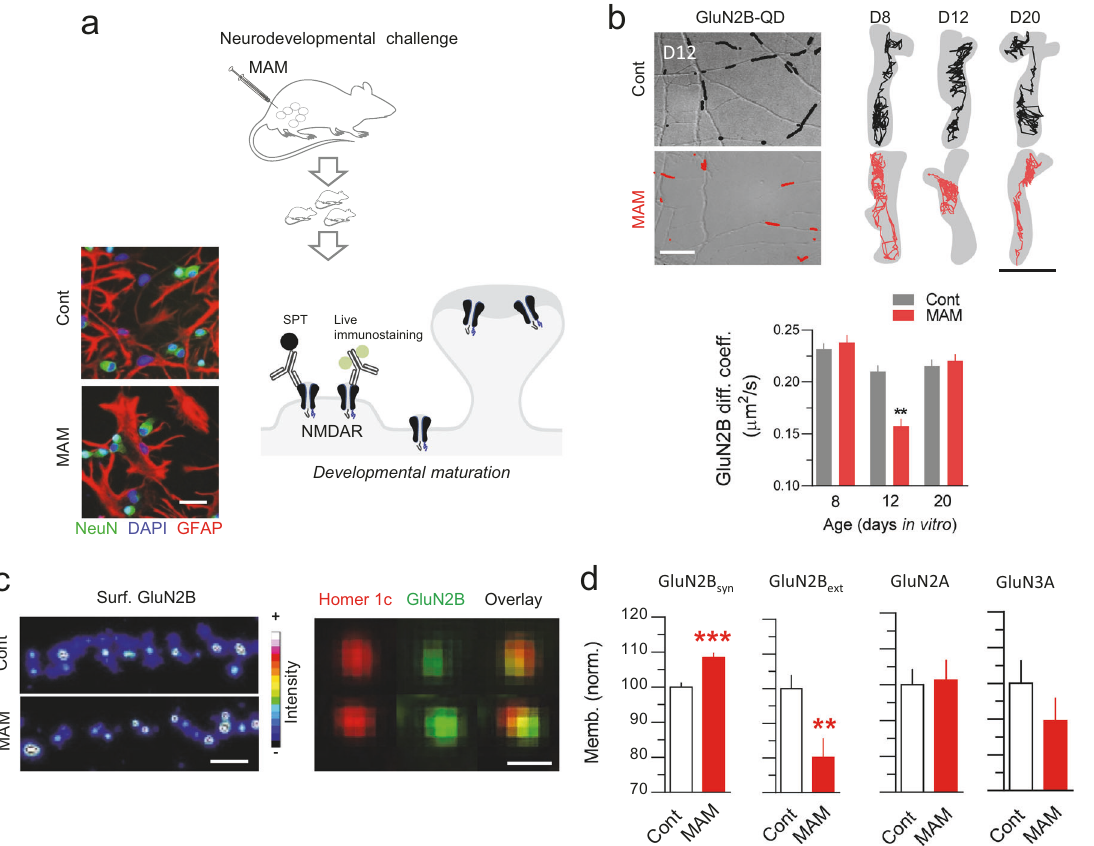
Fig. 4 NMDAR surface dynamics and synaptic plasticity are developmentally impaired in the MAM model. a Schematic description of the experimental work fl ow. Cultured hippocampal networks were made from rat pups. Examples of immuncytochemical staining of neurons (NeuN, green), nucleus (DAPI, blue), and glial cells (GFAP, red) in cultured network at 10 days in vitro from control or MAM-exposed pups. b Representative trajectories (50 ms acquisition) of surface GluN2B-NMDAR-QD complexes on neurons from control or MAM-exposed pups at three developmental stages: days in vitro 6 – 10 (D8), days in vitro 10 – 15 (D12), days in vitro 15 – 22 (D20). Scale bars = 5 µm/300 nm (left/right). Right, Comparison of GluN2B-NMDAR diffusion coef fi cient control or MAM-exposed conditions (D8 cont, n = 1916 trajectories; D8 MAM, n = 1220; D12 cont, n = 2055; D12 MAM, n = 946; D20 cont, n = 1288; D20 MAM, n = 1317; ** p < 0.01, Mann – Whitney test). Data are represented as mean ± sem. c Surface immunostaining of GluN2B-NMDAR onto neurons from control or MAM-exposed pups (synapses were detected with Homer1c-GFP). Scale bars = 5/1 µm (left/right). d Comparison of the GluN2B, GluN2A, GluN3A-NMDAR cluster areas between conditions (GluN2B synaptic cont, n = 2144 clusters; GluN2B synaptic MAM, n = 2468, *** p < 0.001, Student ’ s t -test; GluN2B extrasynaptic cont, n = 1733; GluN2B extrasynaptic MAM, n = 1421, ** p < 0.01, Student ’ s t -test; GluN2A cont, n = 56; GluN2A MAM, n = 41; GluN3A cont, n = 59; GluN3A MAM, n = MAM: 43 ± 3; MAM TAT-NS: 37 ± 10; MAM TAT-2B (P9): 43 ± 6; between GluN2B-NMDAR and PDZ scaffold proteins in synapses MAM TAT-2B (P12): 45 ± 3; ANOVA 1, F = 0.735, P = 0.57). Thus, the and consequently increase GluN2B-NMDAR surface dynamics (Fig. arti fi cial increase in GluN2B-NMDAR surface dynamics during the 6a, b) [38, 50]. The TAT-2B ligand, or its non-sense control version second postnatal week is suf fi cient to prevent the PPI de fi cit (i.e., TAT-NS), was injected in the dorsal hippocampus of control or observed in adult MAM rats. MAM-exposed rats at (1) P9 in order to favor NMDAR dynamics These results suggest thus the impairment in NMDAR surface during the sensitive altered period, or (2) at the end of the diffusion during the second postnatal week produce behavioral sensitive period (P12) (Fig. 6a). At adult stage (P60-65), the de fi cits at adulthood. To directly test this possibility, we used a synaptic content of NMDAR subunits, measured by western blot in cross-link (x-link) strategy [20, 52, 53]. Schematically, surface synaptosomes, was not signi fi cantly different between control, NMDAR are x-linked by an antibody directed against an MAM-exposed, and TAT-2B-injected (P9) rats (Supplementary Fig. extracellular epitope of the GluN2B subunit, which resulted in 5). We then used the gold-standard PPI test in adult rats, a drastic reduction of the receptor surface dynamics (Fig. 6a, b). behavioral assay consistently affected in MAM-exposed rats Anti-GluN2B or control antibodies were injected in the dorsal [35, 51]. We fi rst con fi rmed that MAM-exposed rats poorly hippocampus at P9. At adult stage (P60-65), the synaptic content responded to PPI (Fig. 6c). Remarkably, the PPI de fi cit was of NMDAR subunits, measured by western blot in synaptosomes, abrogated in MAM-exposed rats when the TAT-2B ligand was was not signi fi cantly different between control and GluN2B-x-link injected at P9; the TAT-NS in MAM-exposed rats or TAT-2B in injected rats (Fig. 6b). When the surface dynamics of GluN2B- control rats had no effect (Fig. 6c). When the TAT-2B ligand was NMDAR was impaired from P9, the PPI response at adulthood was injected later, at P12, MAM-exposed rats still exhibit a poor signi fi cantly impaired (Fig. 6c). However, when the injection was response to PPI (Fig. 6c). Note that the reactivity to the startle performed at P12, the PPI response was unaltered (Fig. 6c). Note alone was not difference between groups (Control: 48 ± 3 ms;